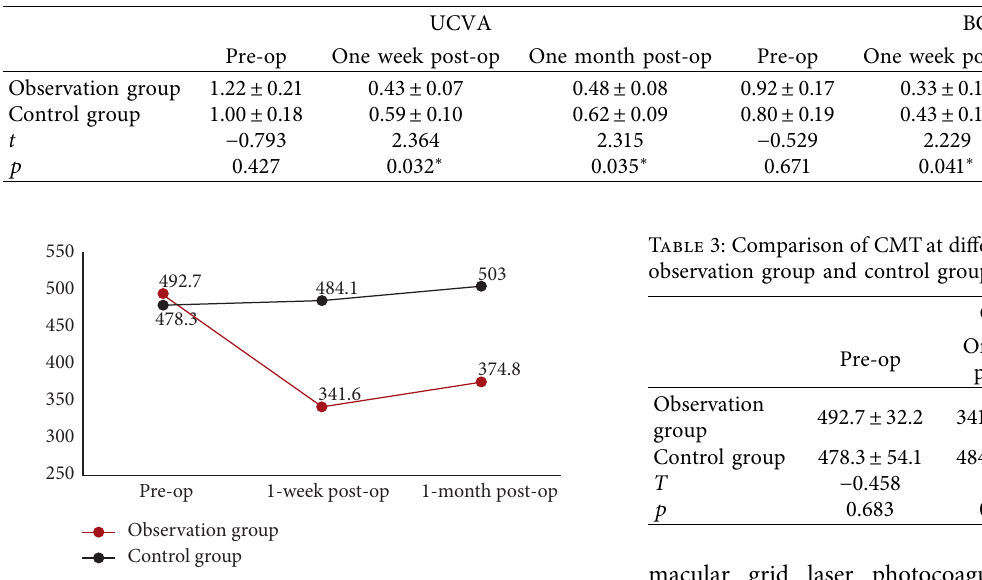
Figure 2: The trend of CMT at different time points between the observation group and control group.